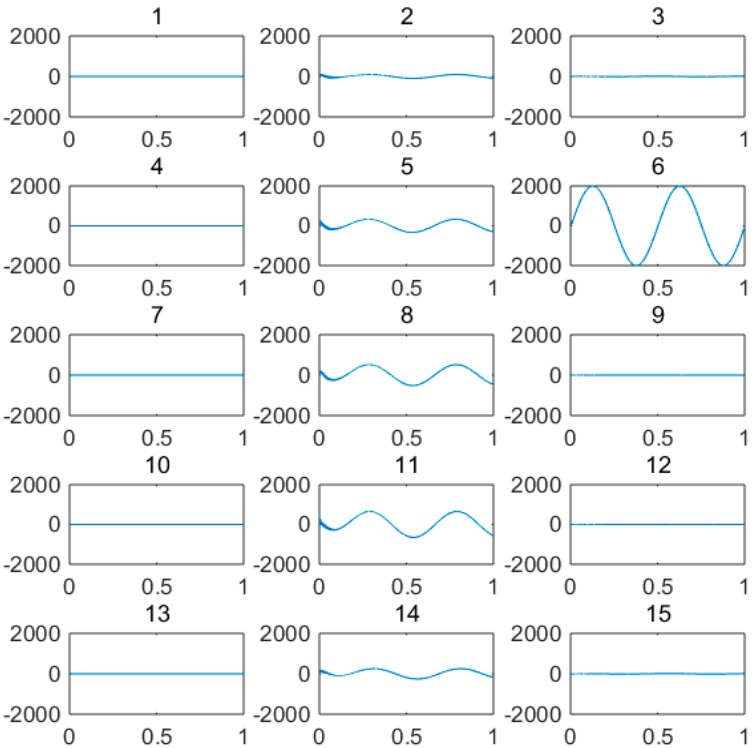
Figure 9. Location estimation of sinusoidal force ( Q w = 1 × 10 − 8 , σ = 1 × 10 − 16 ). Materials 2017 , 10 , 1162